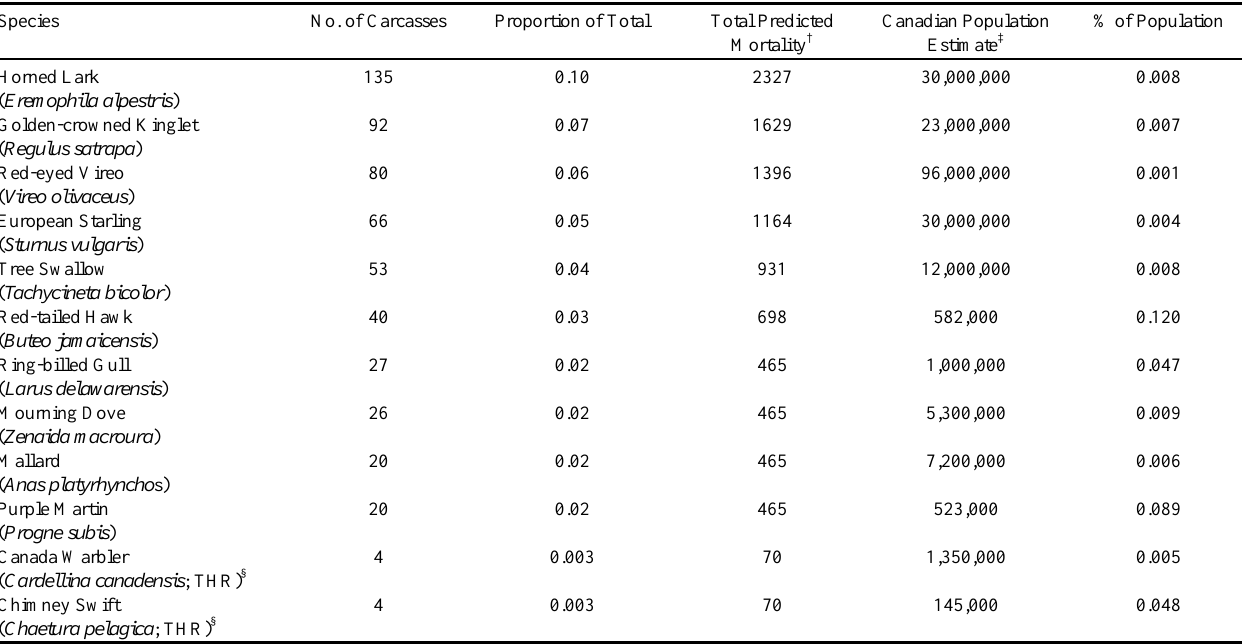
Table 2 . Reported mortality and estimated annual collision mortality and percent of Canadian population impacted for the 10 species most frequently reported as casualties, as well as two species at